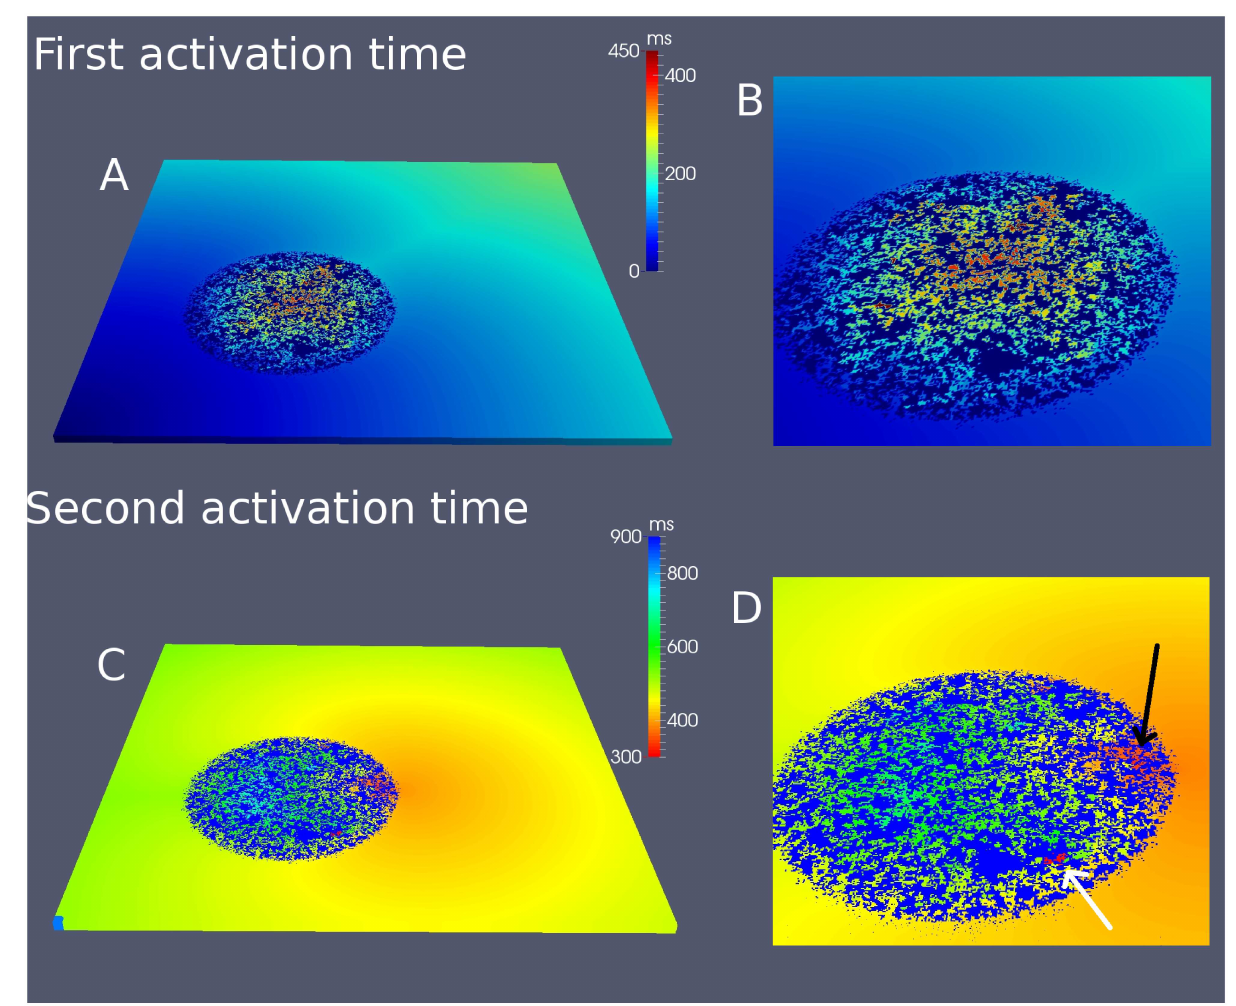
Fig 5. First and second activation time maps in a 3D slab of cardiac tissue. Map of the first activationof the cells corresponding to simulationshown in Fig 4 (A) and the enlargement of the map in the fibrotic area (B). Map of the second activationof the cells corresponding to simulationshown in Fig 4 (C) and the enlargementof the map in the fibrotic area (D). Black arrow shows the origin of the second activation times which producesthe first reentry, and white arrow shows premature activationwhich dies without